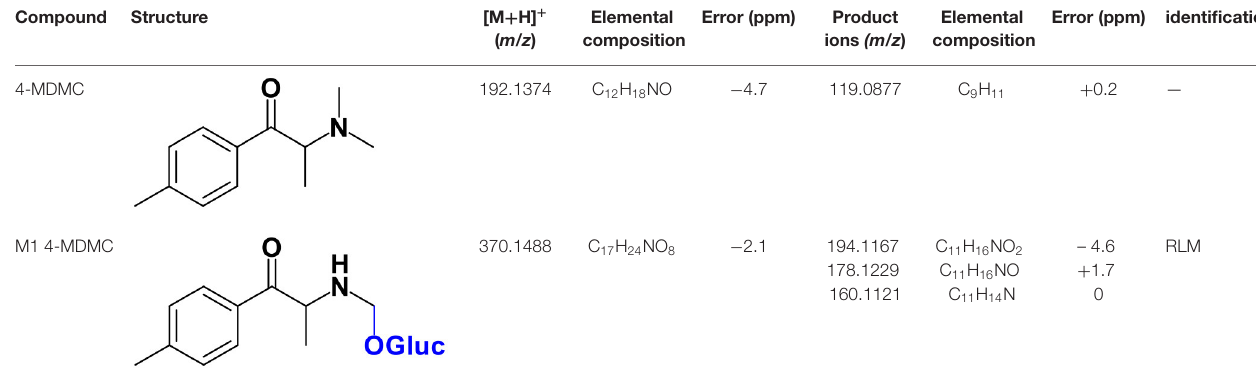
TABLE 3 | Structures for 4-MDMC and its Phase II metabolite identified in HLM and RLM incubations by LC-HRMS/MS (ESI + ) analysis. Compound